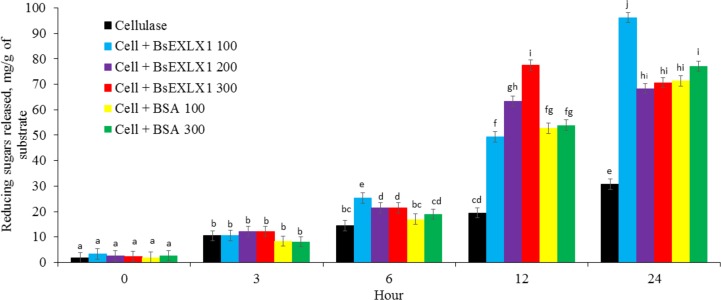
Effects of treatment with cellulase (0.0148 FPU) with or without different doses of bacterial expansin-like protein (BsEXLX1; 0, 100, 200, 300 μg/g) or two doses of BSA (100 and 300 μg/g) on hydrolysis of filter paper (pH 4.8; 50°C,) for different incubation periods (Treatment × Time interaction P < 0.01).Reducing sugars (DNS positive materials calculated on a glucose-equivalent basis materials). Different letters on bars indicate differences (P < 0.05) (Experiment 2).